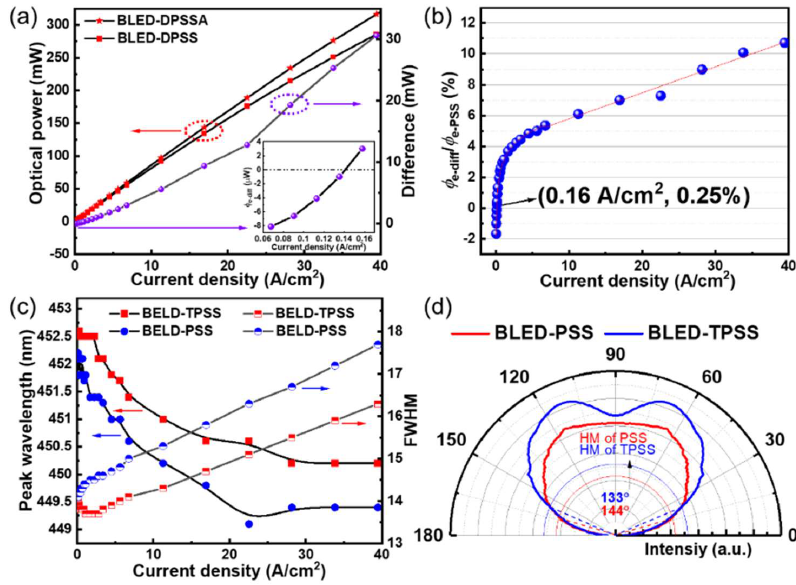
Figure 6. ( a ) φ e and its difference, ( b ) the φ e enhancement, ( c ) λ p and FWHM of BLED-PSS and BLED-TPSS chips as functions of J in , the inset of ( a ) is an expansion of φ e-diff in the range of J in less than 0.16 A/cm 2 ; ( d ) Experimentally measured far-field radiation patterns of BLED-PSS and BLED-TPSS.